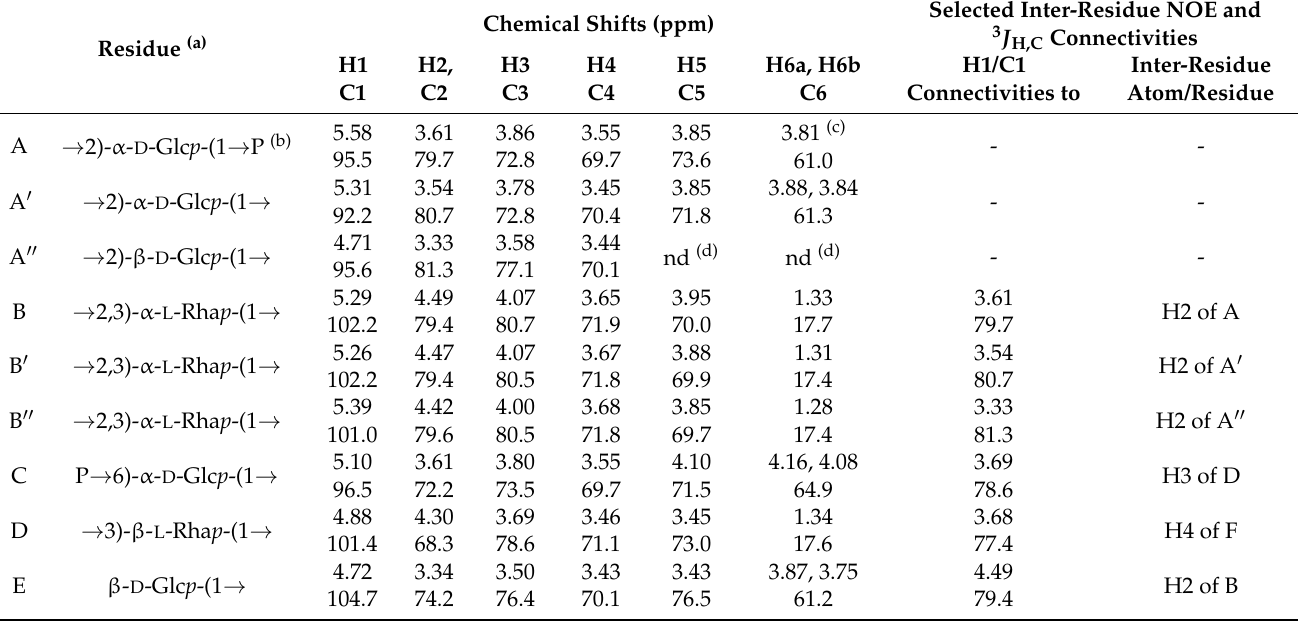
Table 1. The 1 H and 13 C NMR chemical shifts and selected inter-residue correlations from NOESY and HMBC spectra of the EPS isolated from S. gallolyticus DSM 13808.